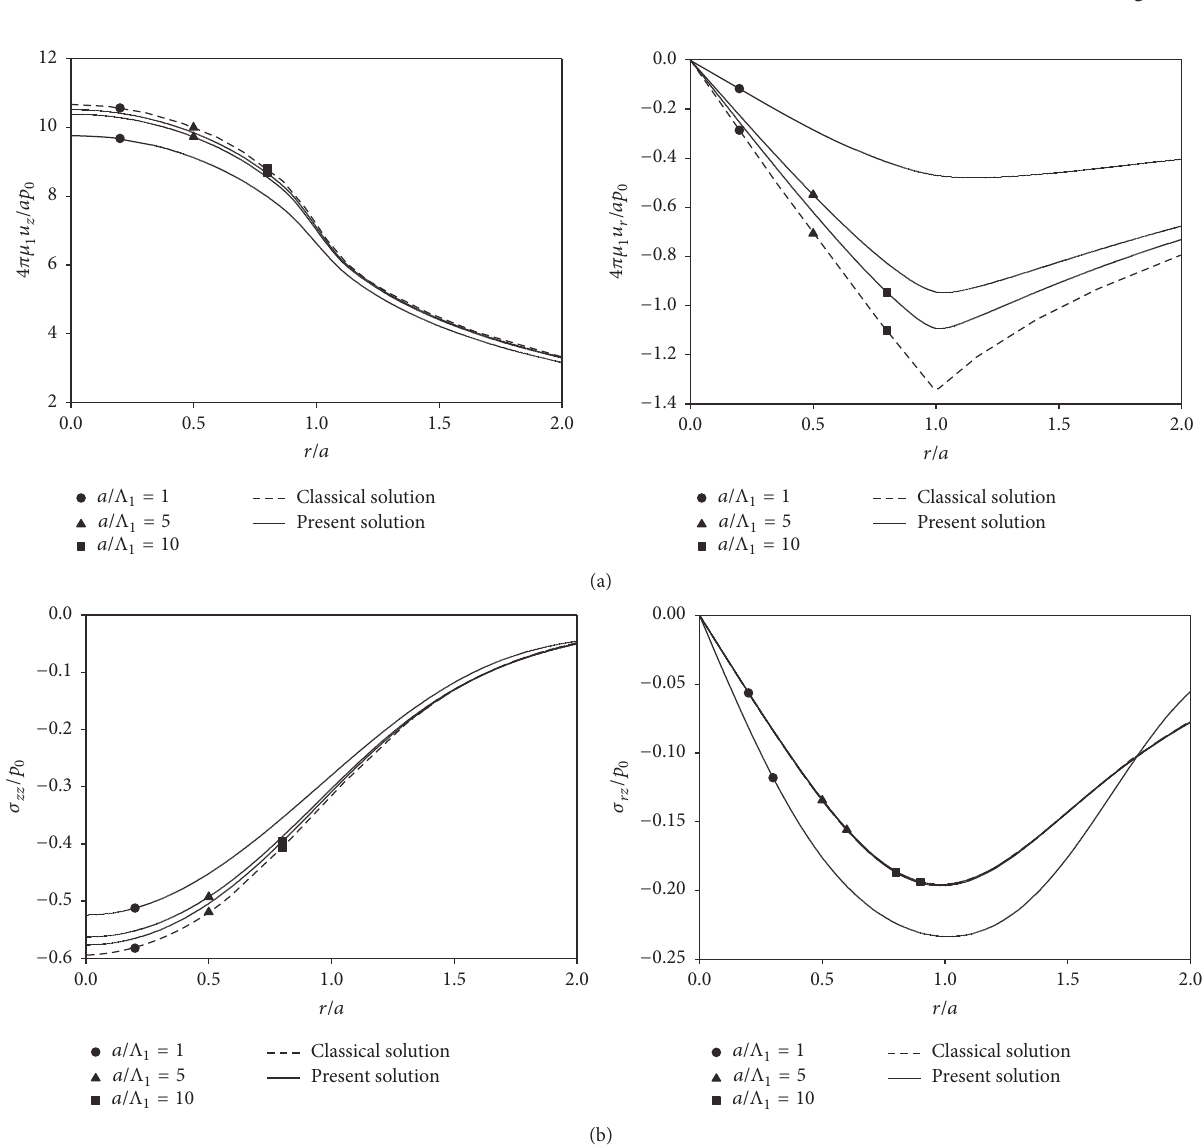
Figure 4: Radial variations of elastic fields under the vertical loading for ℎ/𝑎 = 1 and different values of loading radius (𝑎) : (a) surface displacements (𝑧 = 0) and (b) stresses at the interface (𝑧 = ℎ)